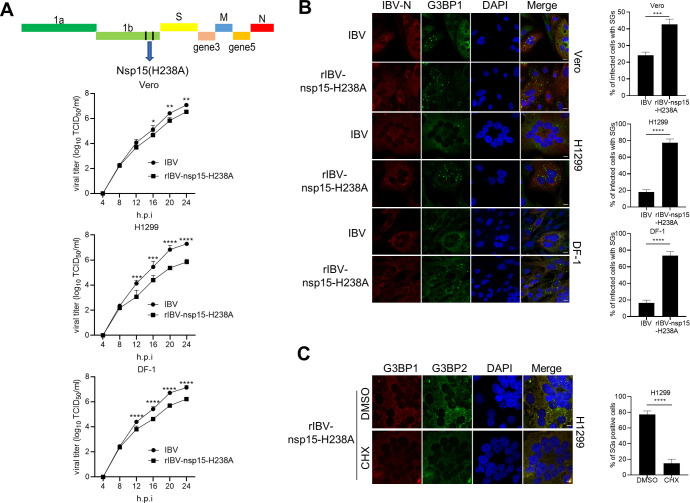
Nsp15-defective recombinant virus rIBV-nsp15-H238A greatly induces canonical SGs.(A) Schematic diagram of the nsp15 mutation site (H238-A) as described in the Material and methods, and the replication dynamics of IBV and rIBV-nsp15-H238A in Vero, H1299, and DF-1 cells. Cells were infected with IBV or rIBV-nsp15-H238A at an MOI of 1. Cell culture supernatants were collected at the indicated times at 4 h intervals and viral titers were determined by TCID50 in Vero cells. The dot graphs showed the growth kinetics of IBV and rIBV-nsp15-H238A of three independent determinations, presented as the mean ± SD. (B) Vero, H1299, and DF-1 cells were infected with IBV or rIBV-nsp15-H238A at a MOI of 1 for 20 h, followed by immunostaining. Infected cells were identified with anti-IBN-N (red) and the SGs were detected with anti-G3BP1 (green). Cell nuclei were stained with DAPI (blue). The bar graphs on the right panel showed the percentage of SGs positive cells to total infected cells, which were calculated over 20 random fields, presented as the mean ± SD. P values were calculated by Student’s test. ***, P < 0.001; ****, P < 0.0001. (C) H1299 cells were infected with rIBV-nsp15-H238A for 20 h and treated with 100 μg/ml of cycloheximide (CHX) or an equivalent volume of DMSO for 1 h, followed by immunostaining with anti-G3BP1 or anti-G3BP2 antibodies. The bar graphs showed the percentage of SGs positive cells to total cells, which were calculated over 20 random fields, presented as the mean ± SD. ****, P < 0.0001. The representative images of three independent experiments were shown. Scale bars: 10 μm.